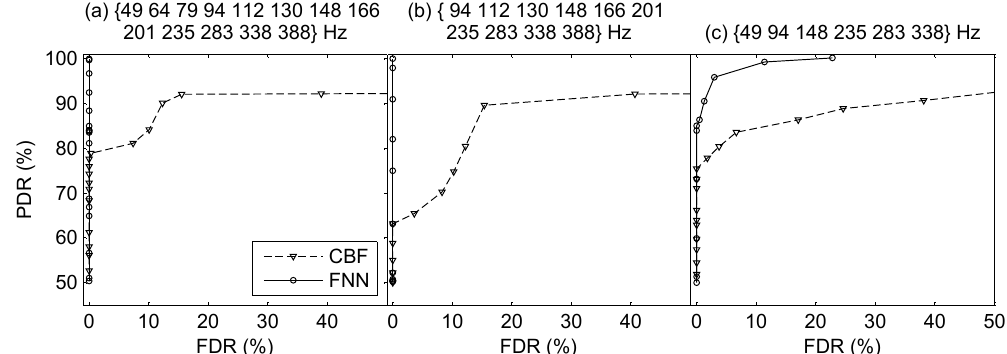
Figure 15. ROC curves of direction finding using different frequency bins in the two-source scenario using the real experimental data.